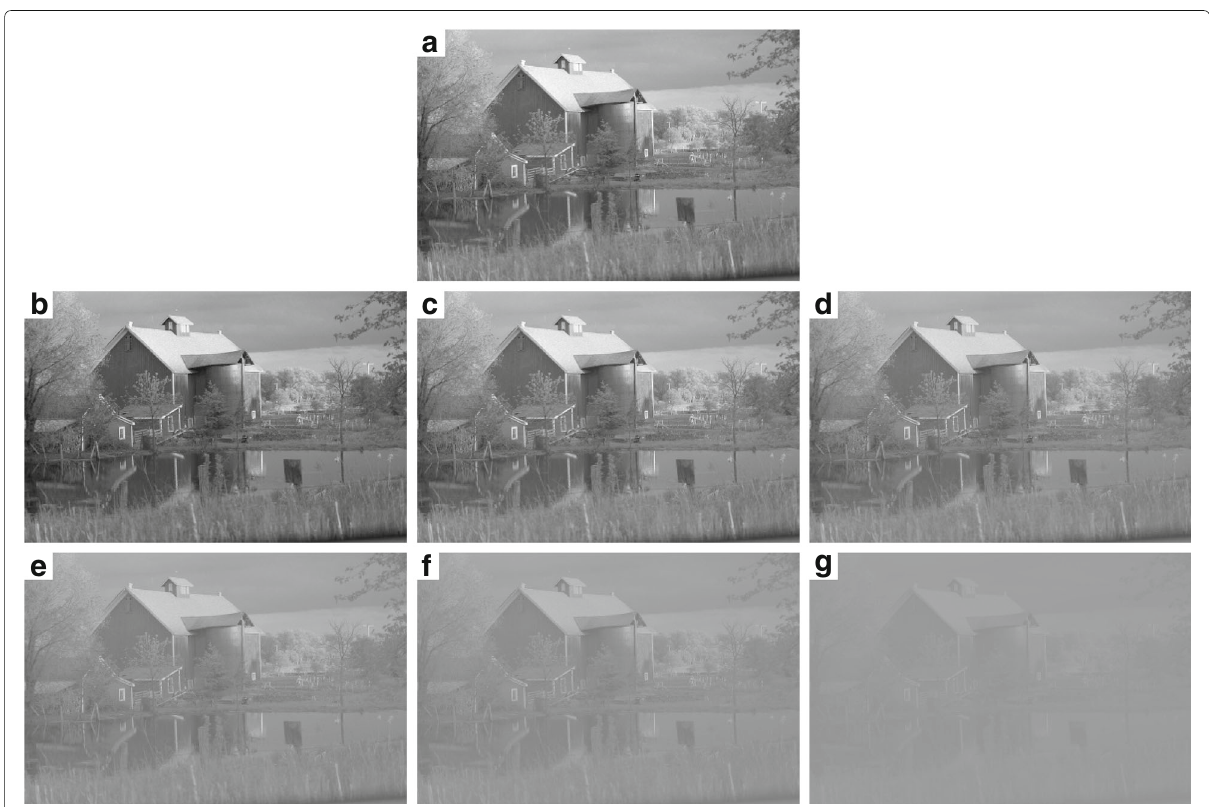
Fig. 3 Contrast distortions in dataset 2. Original image ( a ), − 50% compression ( b ), 10% compression ( c ), 30% compression ( d ), 50% compression ( e ), 70% compression ( f ), 90% compression ( g